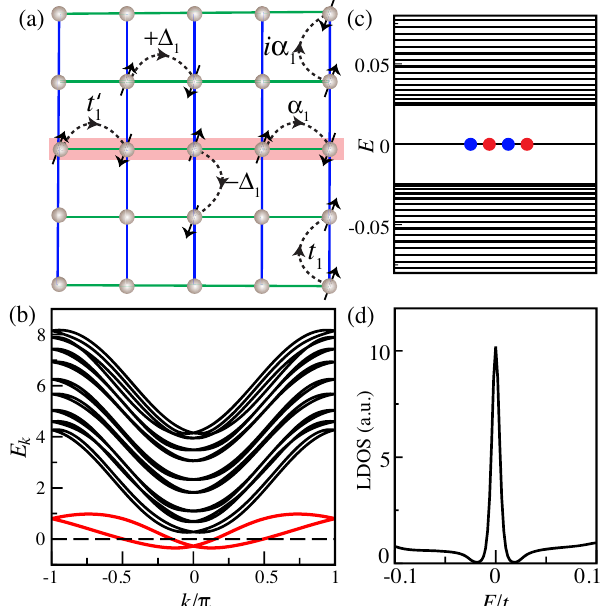
FIG. 7. (a) Schematic illustration of a RALD (shaded region) embedded in the antinodal direction of a 2D d -wave super- conductor. The green and blue bonds correspond to positive and negative pairings, respectively. (b) Normal state band dispersions. The momentum is along the x direction of the line defect with L L ¼ 1000 and L ¼ 10 . The red lines correspond to D ¼ ð 1 ; 0 Þ ð 0 ; 1 Þ the incipient impurity bands split by Rashba SOC. The black lines correspond to the bulk bands. (c) The energy spectrum of the 2D superconductor with L D ¼ 500 , extending from (250,5) to (750,5). The four zero-energy states are represented by the blue and red dots. (d) The LDOS spectrum at either end of the line defect. A temperature broadening ( T ¼ 0 . 0025 ) is